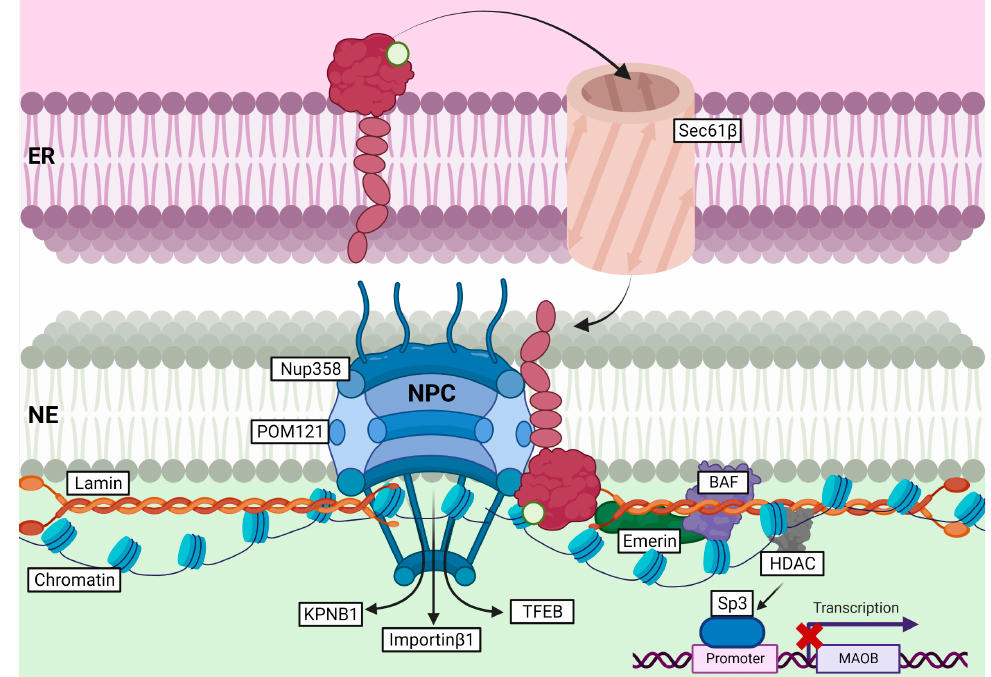
Figure 6. Role of S1R at the ER-NE contact site and its role in nucleocytoplasmic transport, stabili- zation of the NPC, and gene transcription.